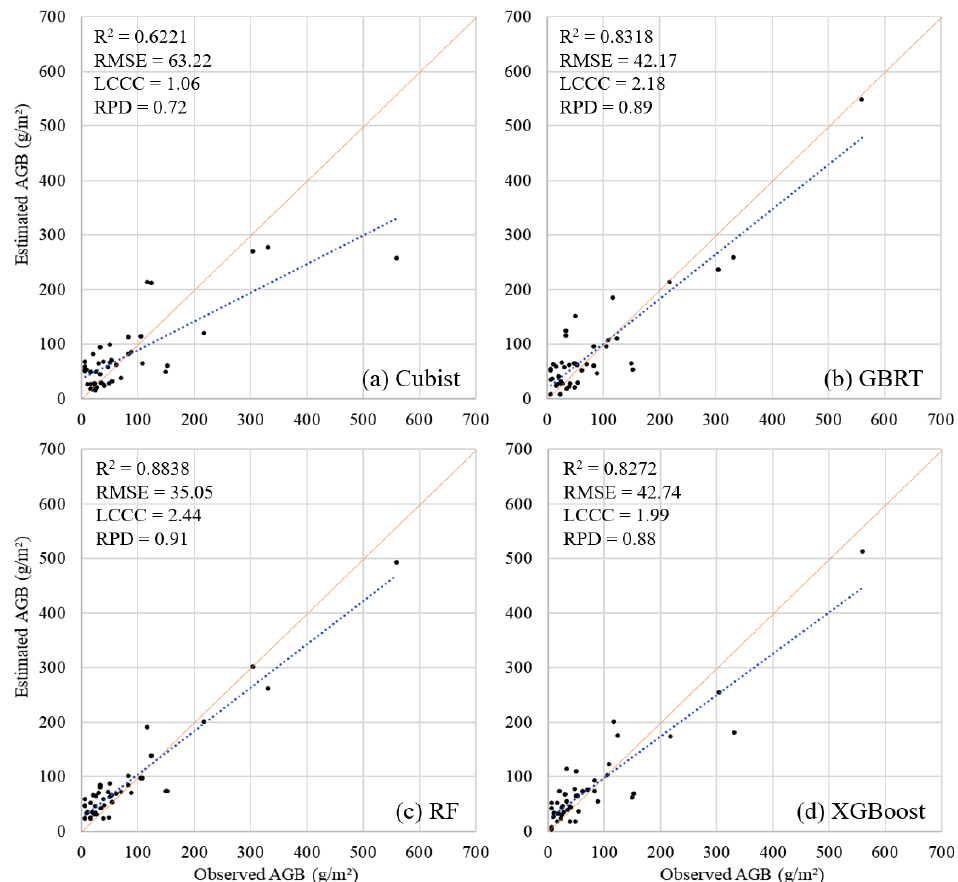
Figure 7. Scatter plots of the estimated and observed AGB based on ( a ) the Cubist, ( b ) the GBDT, ( c ) RF and ( d ) the XGBoost model using the test